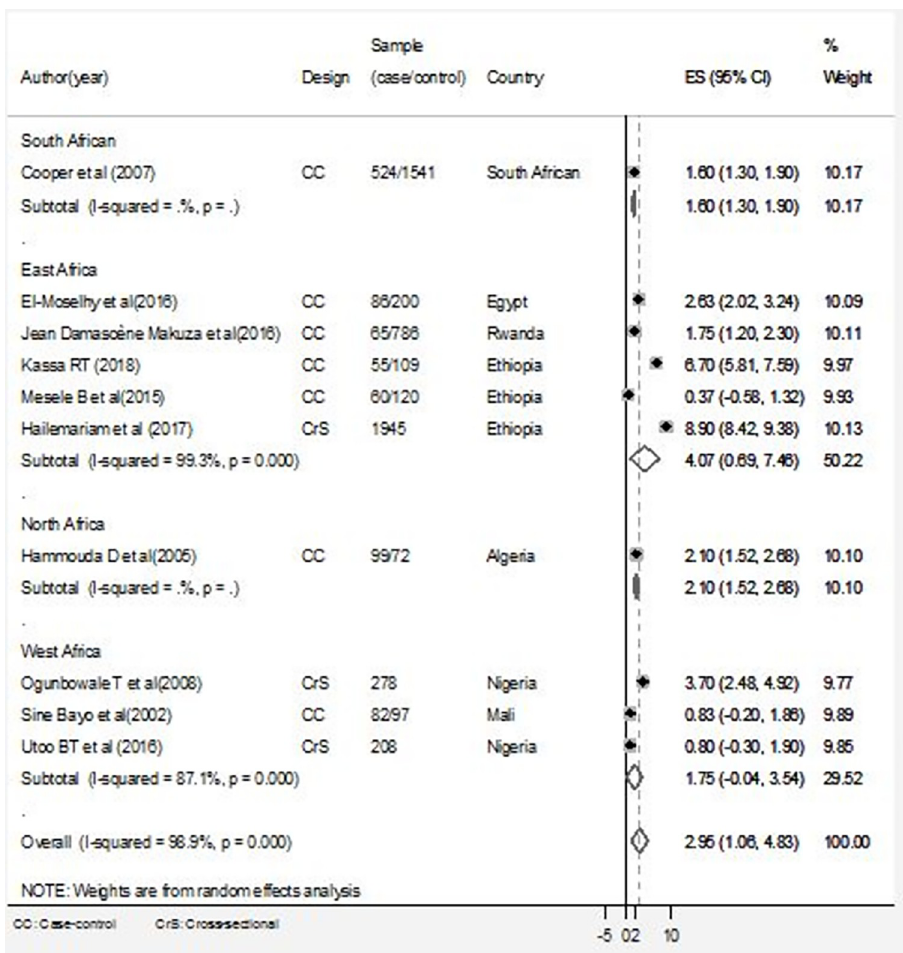
Fig 3. Forest plot of pooled estimates of the association between early sexual intercourse and having cervical cancer: Subgroup analyses by regions, March 2022.